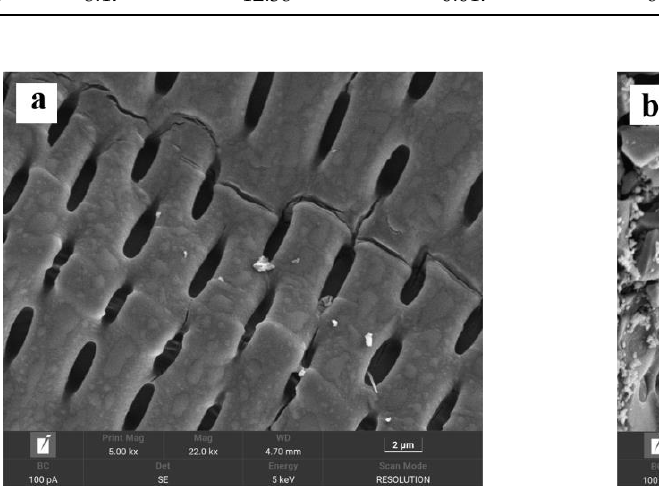
Figure 1. SEM images of BC ( a ) and E–CBC ( b ).